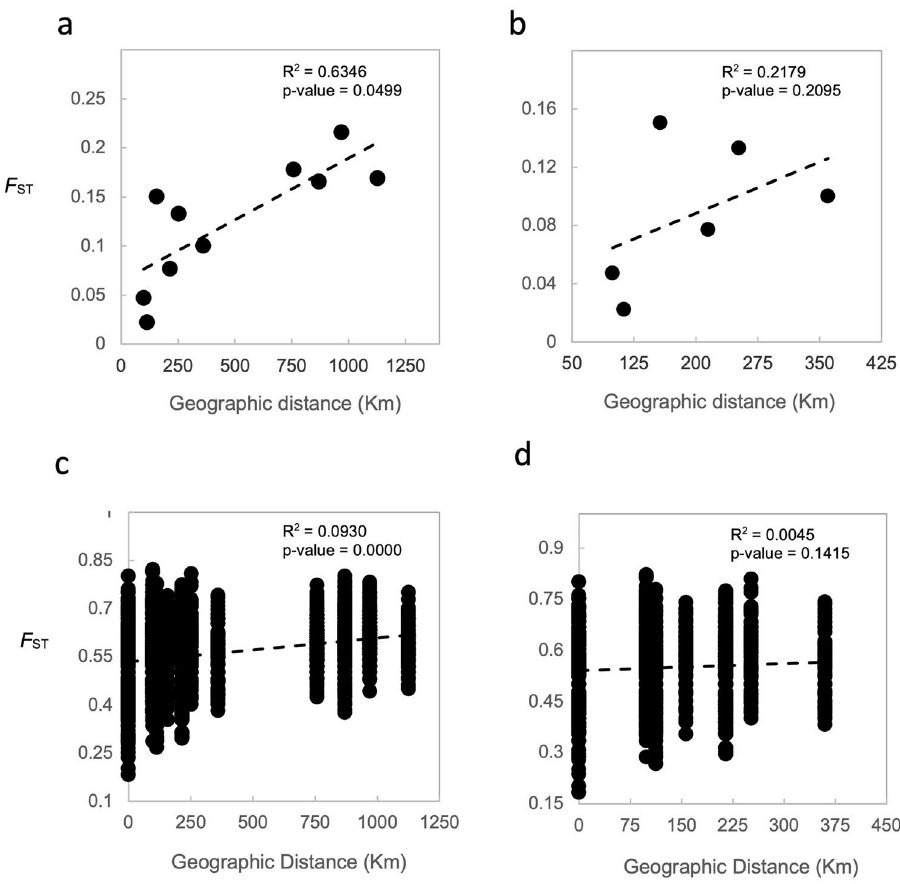
Figure 5. Isolation by distance (IBD) analyses. Correlation between geographic distance and genetic divergence F ST for: ( a ) all five sampling locations; ( b ) the four southern sampling locations (i.e., excluding Kainji Lake); ( c ) considering all 83 individuals sampled separately; and ( d ) considering the 60 individuals from the southern sampling locations